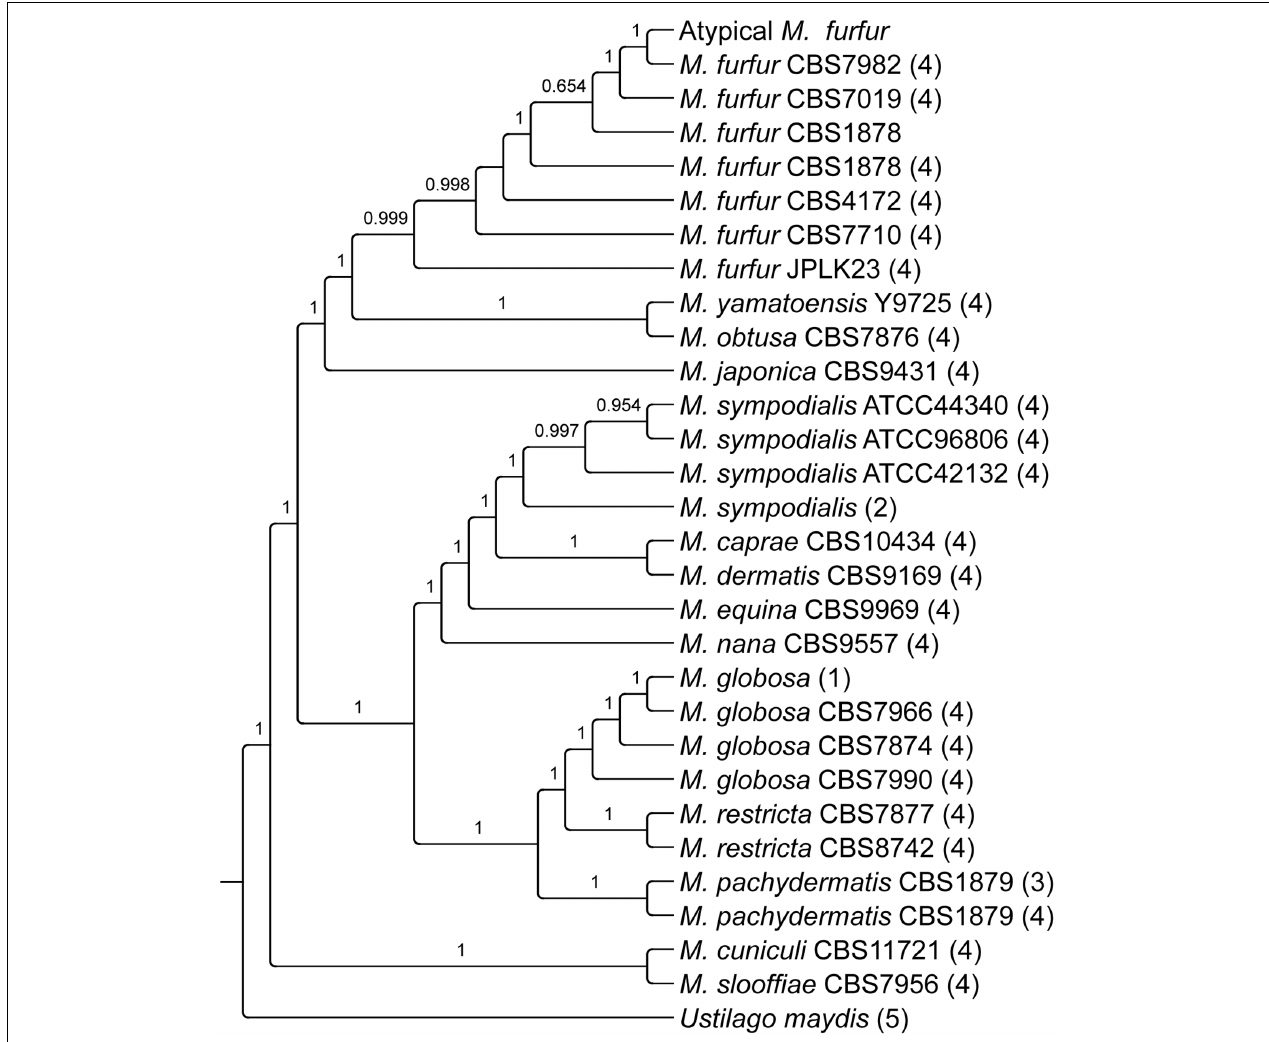
FIGURE 1 | Phylogenetic analysis of the Malassezia genus reconstructed from highly conserved genes identified with BUSCO 2.0 (Simão et al., 2015). (1) Xu et al., 2007, (2) Gioti et al., 2013, (3) Triana et al., 2015, (4) Wu et al., 2015, (5) Kämper et al.,